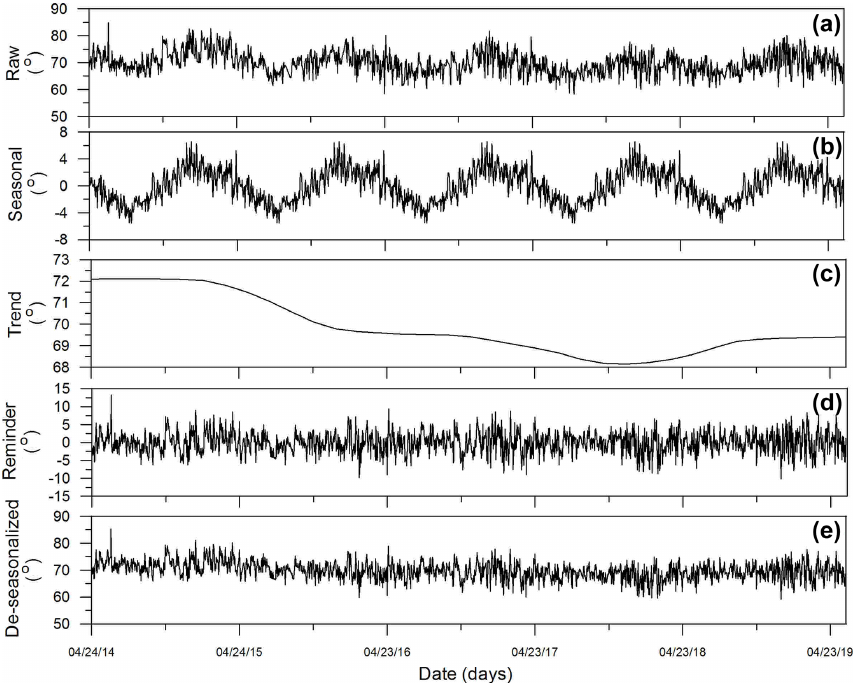
Figure 2. Decomposition plots of daily temperature time-series at SF2 station: (a) raw temperature data, (b) seasonal time-series for the investigated time range, (c) trend, (d) remainder and (e) de-seasonalized data. Table 1. Results of Rayleigh criterion. Grey rows separate the statistics relative to different TIR datasets. The columns, from the left to the right, show: (1) period, T ; (2) [ T min , T max ] interval; (3) period of the lower adjacent peak of P atm ; (4) period of the higher adjacent peak of P atm ; (5) period of the lower adjacent peak of T atm ; (6) period of the higher adjacent peak of T atm ; (7) Summary results. When an adjacent period results to be statistically distinct from T (outside [ T min , T max ]), bold font is used, otherwise a statistical link is possible ( T inside [ T min , T max ]). All the periods are in